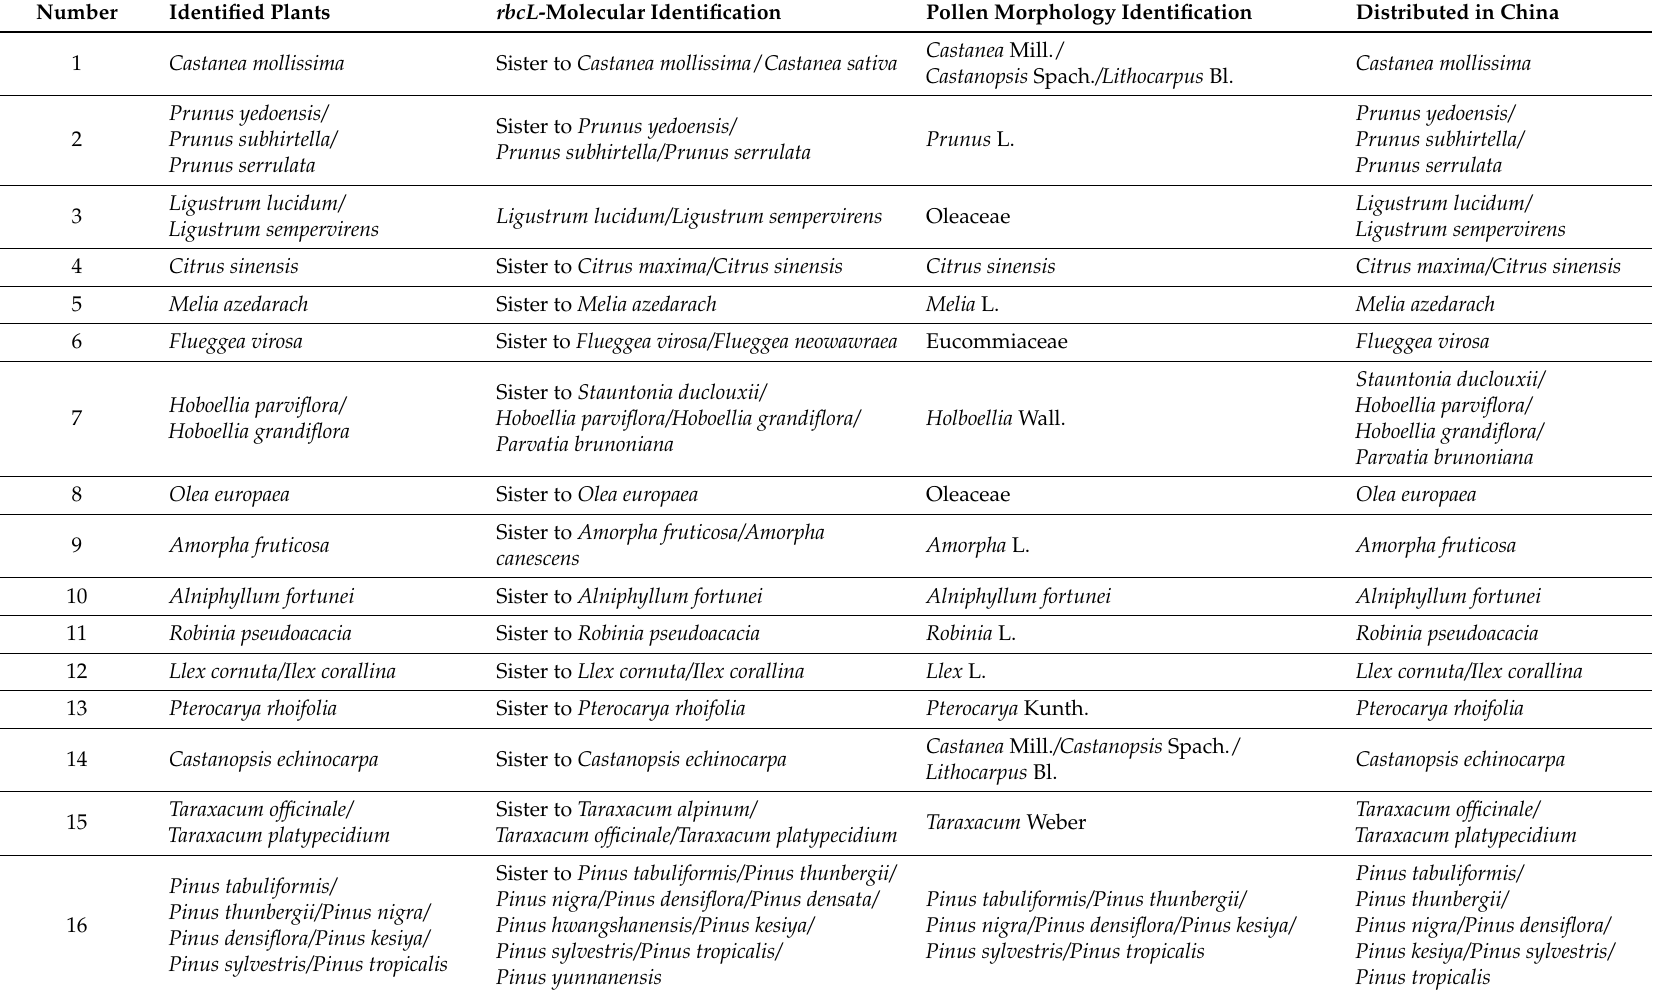
Table 1. Molecular and morphological identification of plant species by identifying